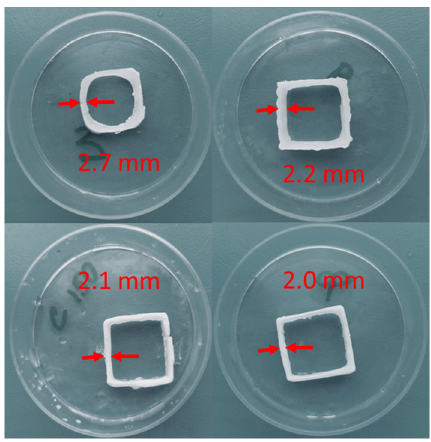
Figure 5. Changing the wall thickness of products with complex geometry depending on the diameter of the extruder nozzle. Table 3. Size of the 3D-printed model.